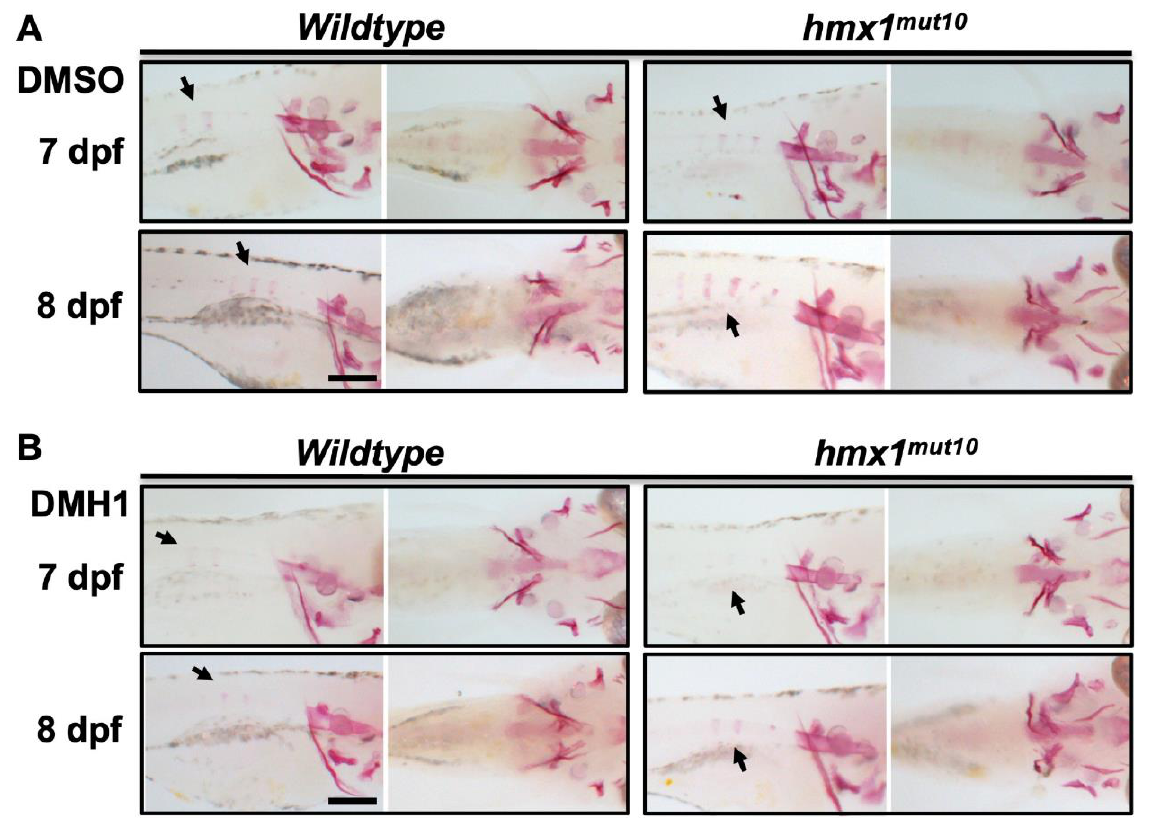
Figure 5. DMH1-mediated inhibition of BMP signaling reduces the progression of vertebral miner- alization : Wildtype and hmx1 mut10 embryos were treated with 50 μ M DMH1 at 2 dpf and placed in E3 medium at 3 dpf. Alizarin red staining to detect mineralized structures was performed at 7 and 8 dpf (left, lateral view, right ventral view). Wildtype and hmx1 mut10 control embryos treated with DMSO ( A ). Precocious vertebral mineralization was inhibited in DMH1-treated hmx1 mut10 embryos at 7 dpf ( B ). At 8 dpf, treated hmx1 mut10 embryos still presented a vertebral mineralization pattern similar to wildtype embryos ( B ). Bar, ( A , B ) 500 μ m.